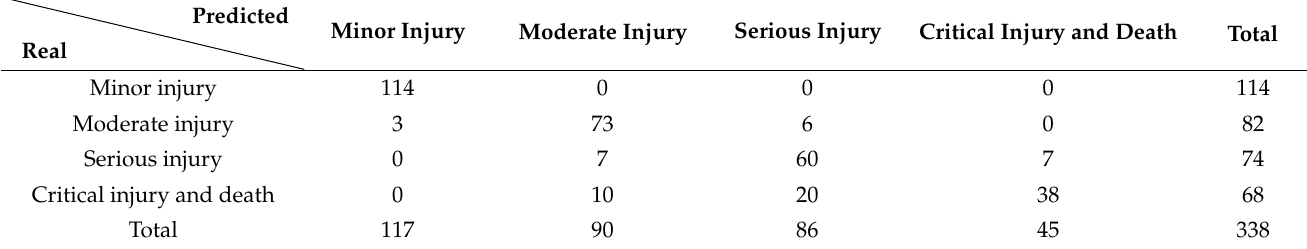
Table 6. Confusion matrix of injury consequence identification.